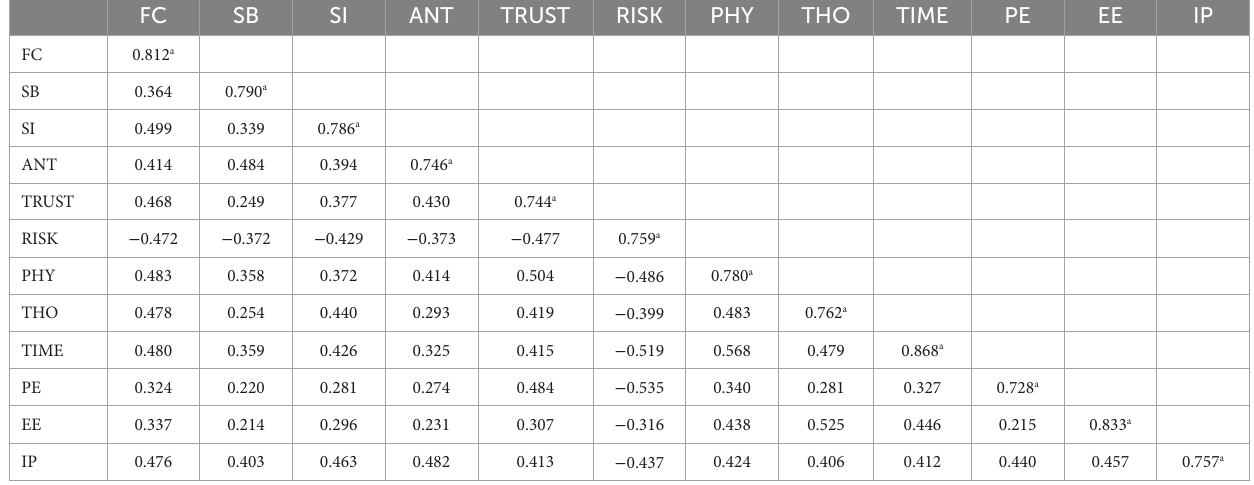
TABLE 6 Discriminant validity of the model (implied correlation matrix). FC SB